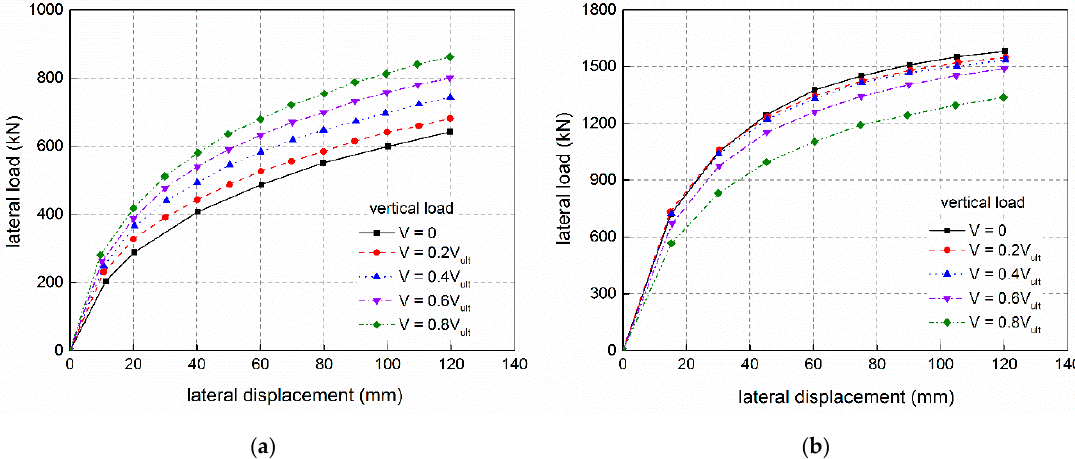
Figure 3. Lateral load-displacement response of piles with increasing applied vertical loads, reported in Karthigeyan et al. [30]: ( a ) sandy soil, ( b ) clayey soil .